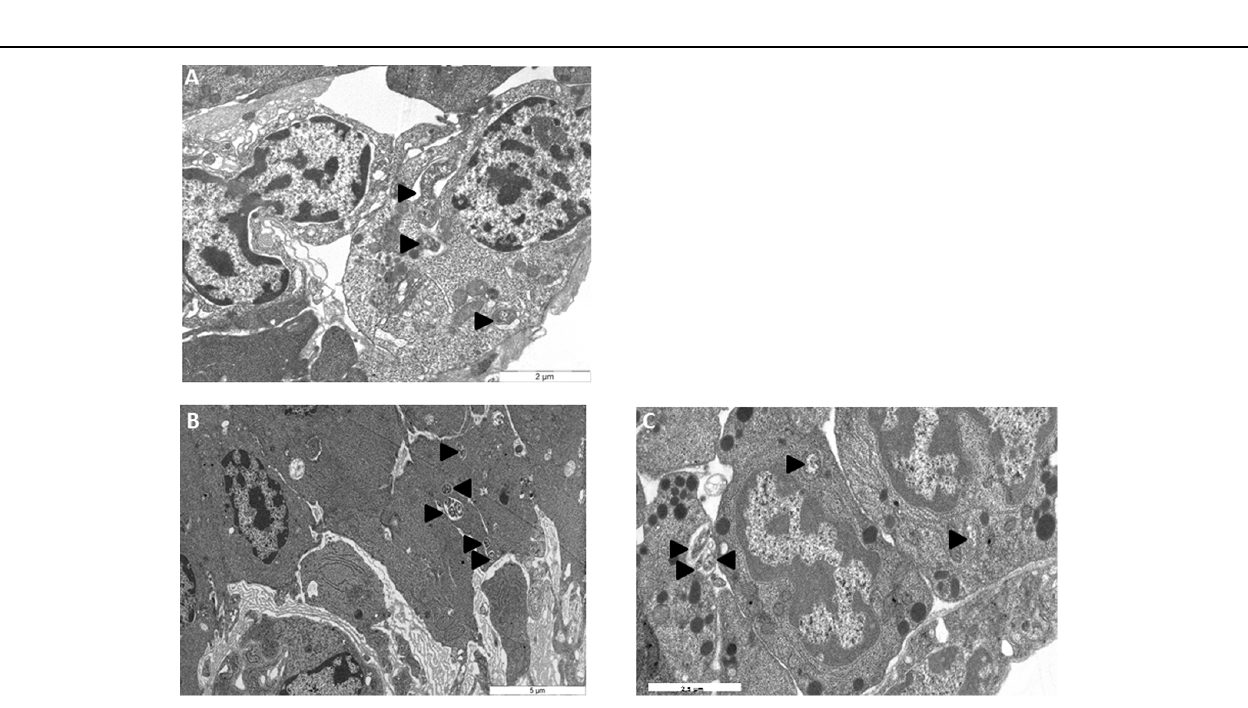
Frontiers in Microbiology |